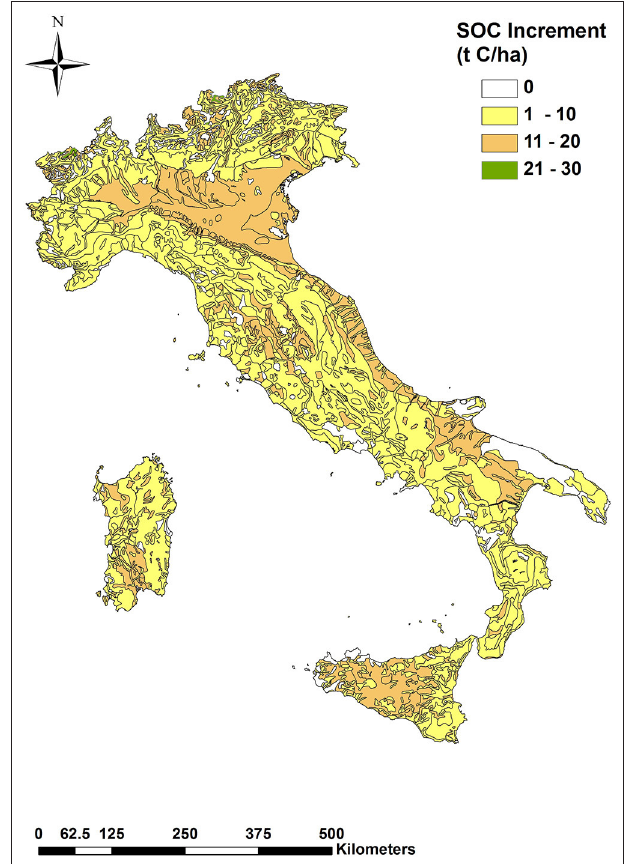
FIGURE 6 | Map of modeled increase in soil organic C (SOC, t ha − 1 ) after 100 years of meat and bone meal addition (1.0t C ha − 1 y − 1 ) to all the Italian soils with agricultural land use (climate scenario PCM B1). The increase in SOC refers to the business as usual scenario in